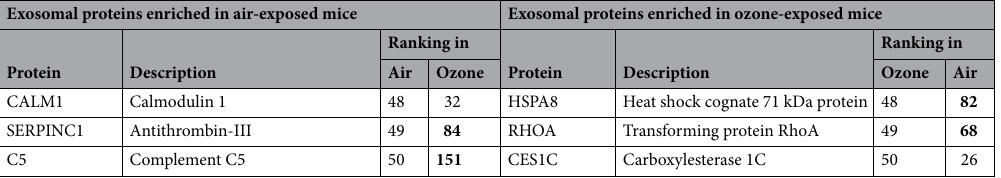
Table 1. Top 50 protein signatures enriched in air- and ozone-exposed mice. Ranking column on the right of Air (or Ozone) column indicates the ranking of the protein in the ozone (or air) group. Bold text indicate that the corresponding protein is not present in top 50 in the respective exposure